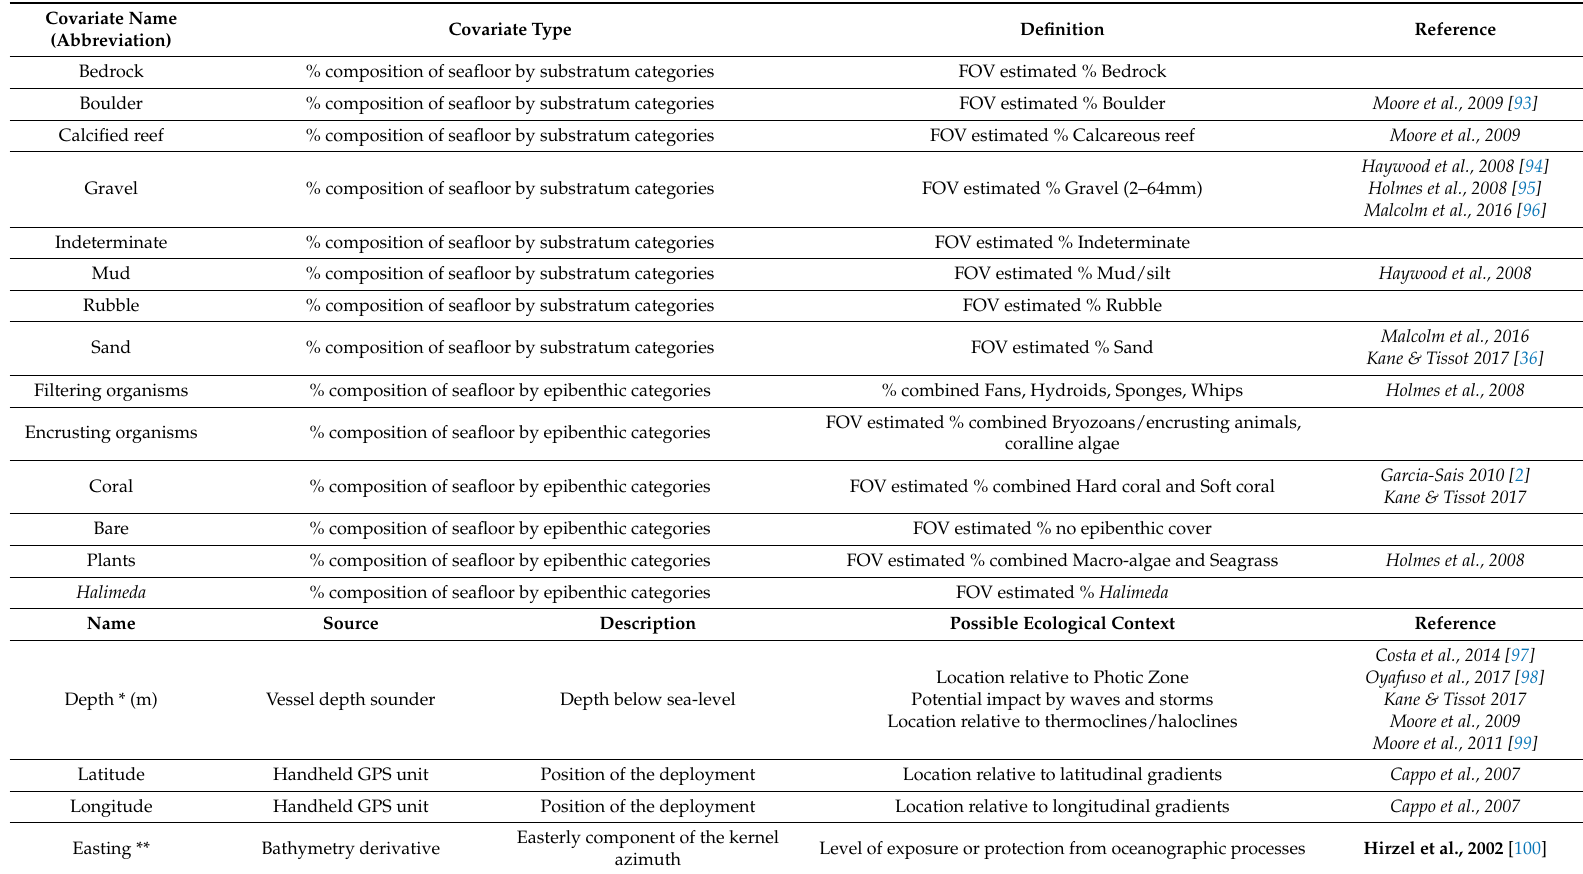
Table 1. Explanatory covariates from multibeam echo sounding technology and estimates from the Baited Remote Underwater Video Station field-of-view (FOV). Some epibenthic and substratum categories were pooled for combined groups of benthos. Primary and secondary (derived) features from bathymetry and backscatter raster datasets: * Raw raster data. ** Applied as a 3 × 3 kernel on bathymetry after it was averaged using kernels with a radius of 5 and 50 pixels. *** Applied kernels with a radius of 5 and 50 pixels. References where these multibeam derivatives are described are in bold. Example references where these factors have been highly influential on fish or benthic assemblages are noted in